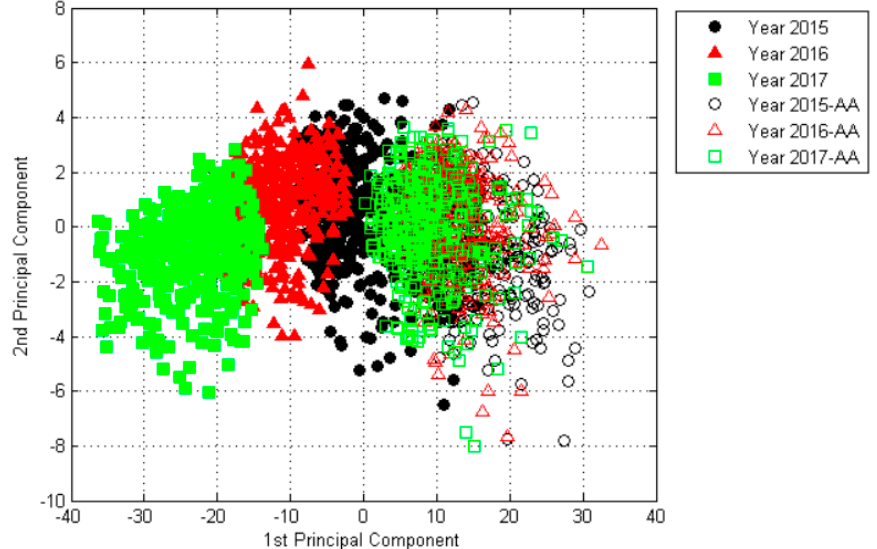
Figure 2. Principal component analysis (PCA) results for raw data based on the spectral data of all six seed groups. AA: artificial ageing.